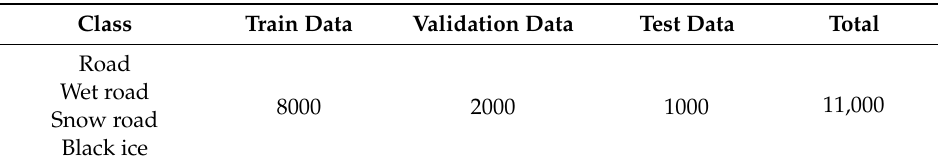
Figure 3. ( a ) Numbers of 1000 data are randomly selected and set as test data; ( b ) data augmentation with ImageDataGenerator functions; ( c ) train data and validation data set at 8:2 ratio. Table 7. Dataset for class.